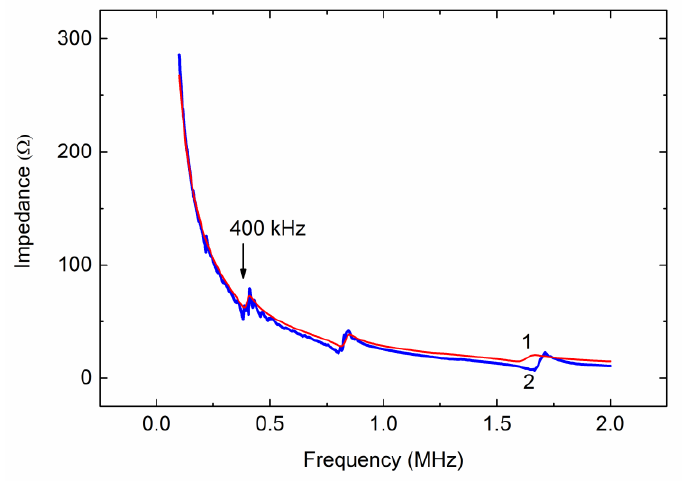
Figure 3. Calculated (1) and measured (2) impedance magnitude response for piezoelectric transducer shown in Figure 2a.